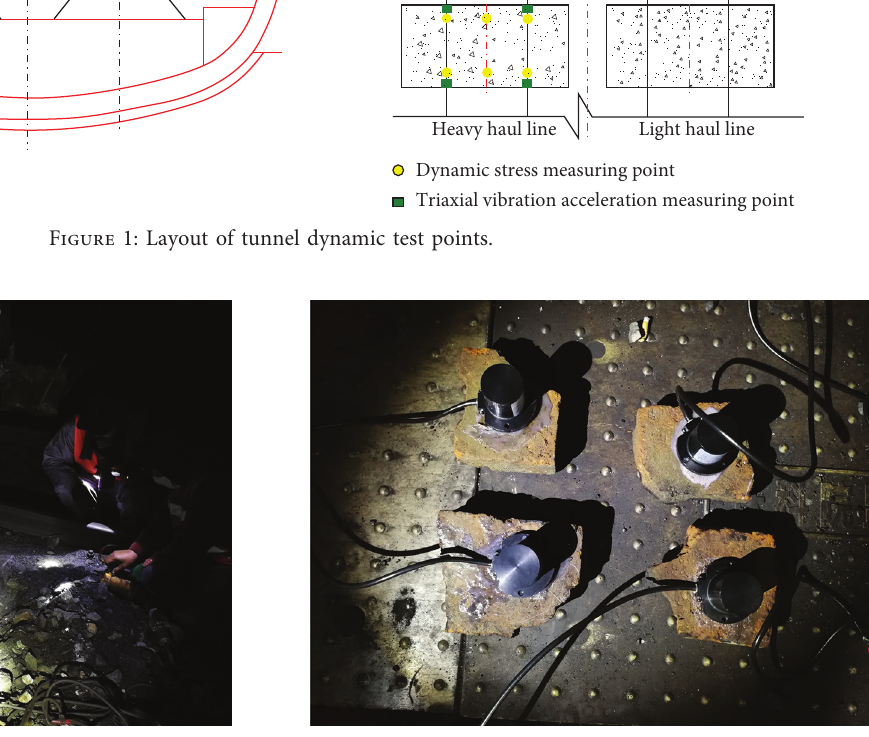
Figure 2: Field test site. Figure 3: Fixing of three-axis vibration acceleration